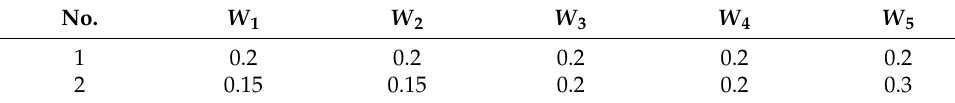
Table 9. Two sets of weights.